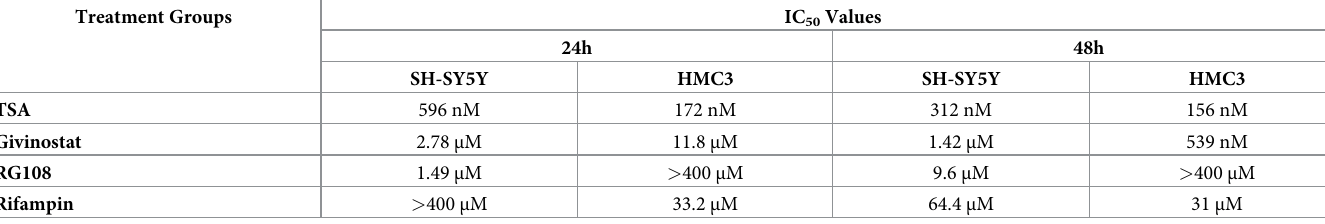
Table 1. IC 50 values of SH-SY5Y and HMC3 cells. Treatment